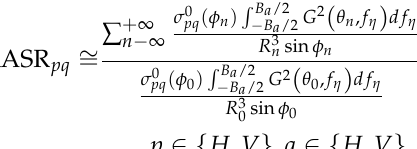
( · ) indicates the inverse t